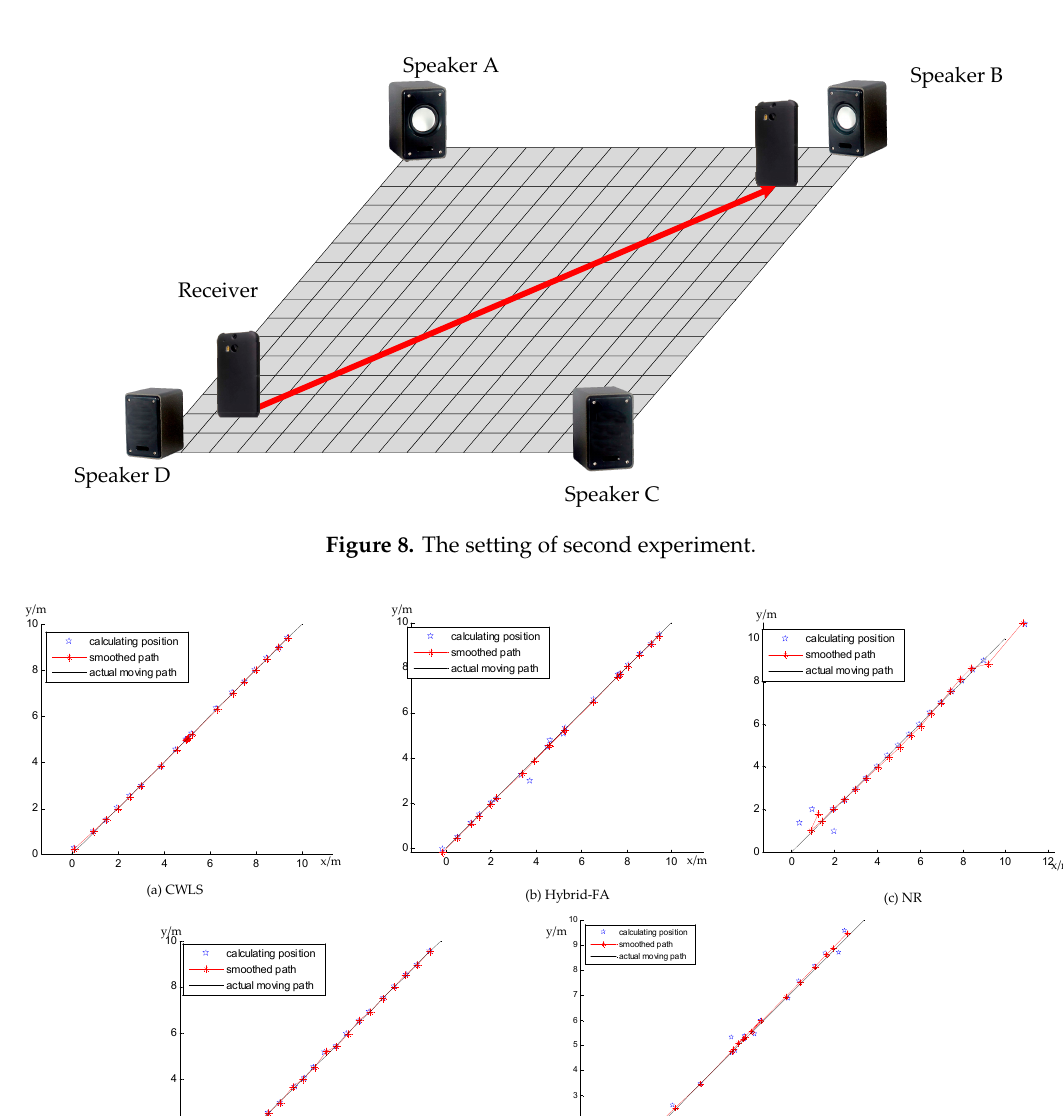
(b) Figure 7. The results of the first experiment. ( a ) The RMSE of the five methods. ( b ) The number of bad results from the five methods.